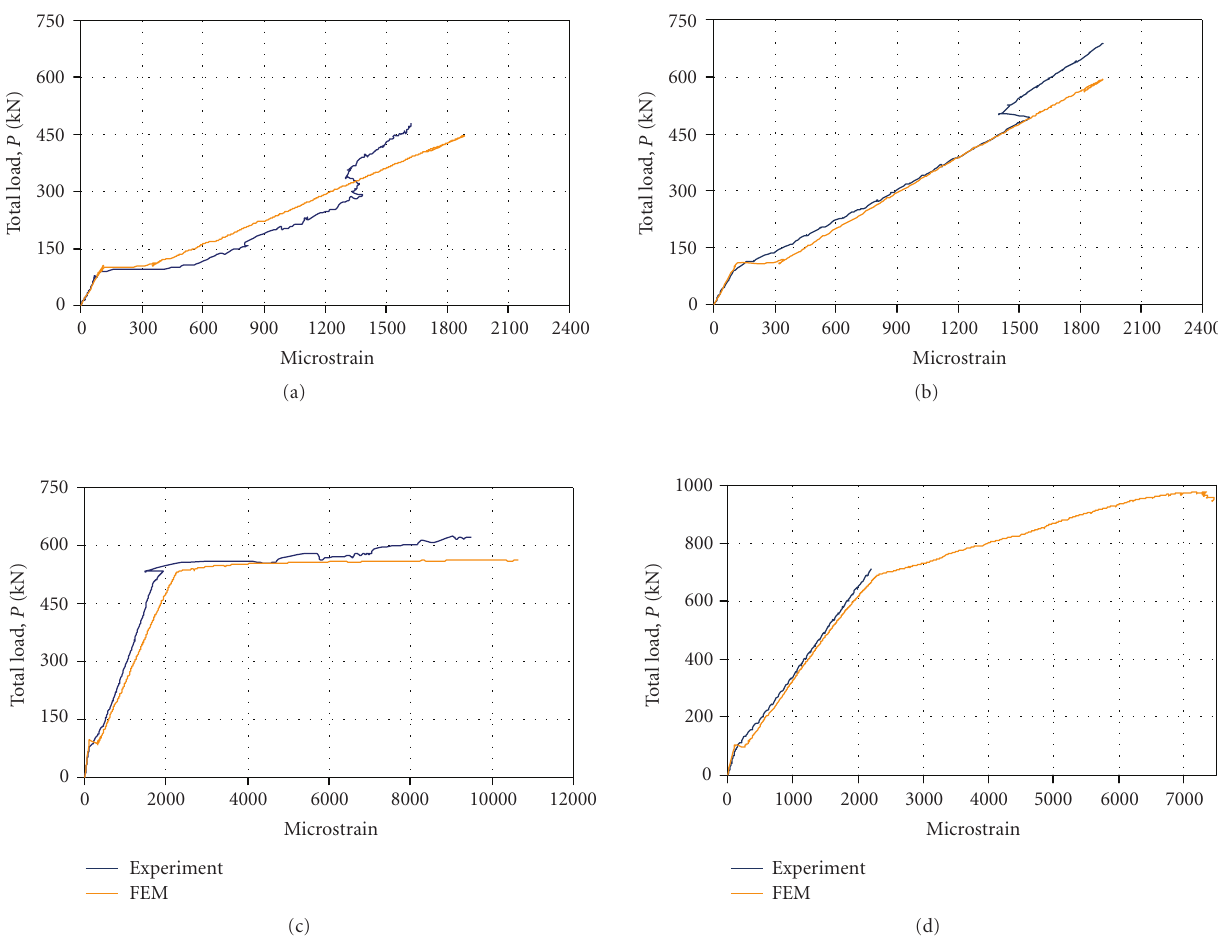
Figure 4: Load-tensile strain plots for main steel reinforcing bar. (a) Unstrengthened beam; (b) flexural-strengthened beam; (c) shear- strengthened beam; (d) flexural plus shear-strengthened beam (experimental beam did not fail).